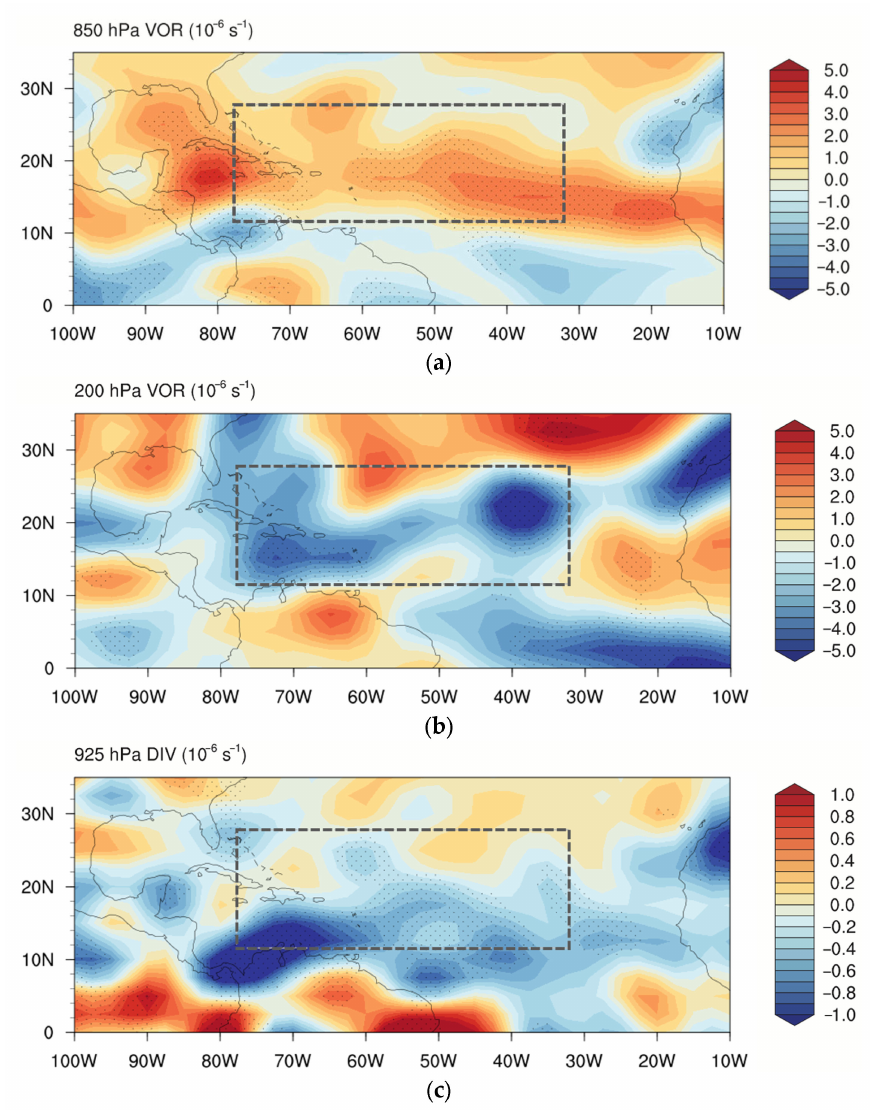
Figure 7. Similar to Figure 6, but for the ( a ) 850 hPa and ( b ) 200 hPa vorticity (unit: 10 − 6 s − 1 ), ( c ) 925 hPa divergence (unit: 10 − 6 s − 1 )